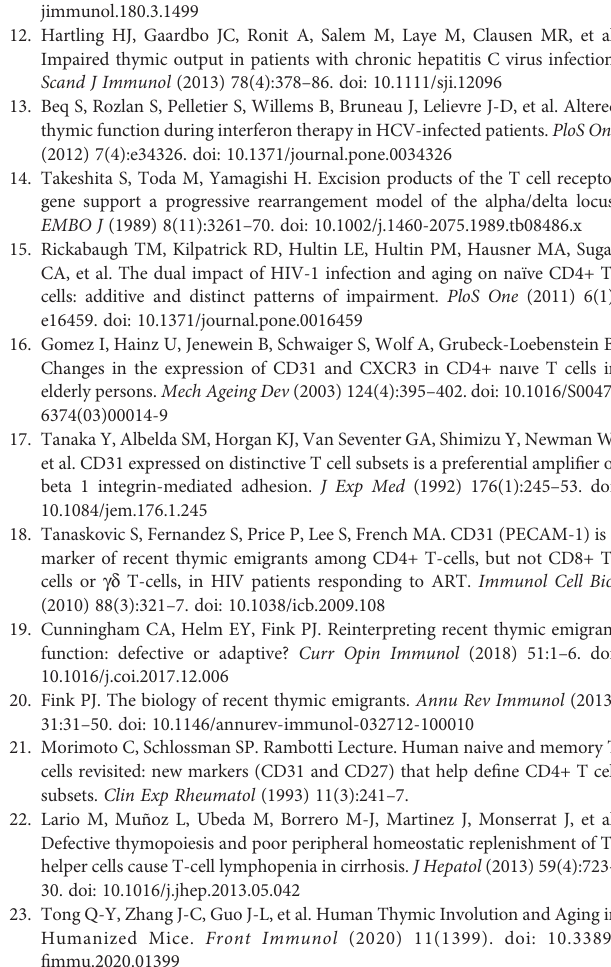
Supplementary Figure 1 | Flow cytometry gating strategy for naïve CD4+ T cells and corresponding subsets. Supplementary Figure 2 | Naïve CD4+, CD4+CD31+ and CD4+CD31- proportions and counts are lower in HCV infected individuals compared to age- range matched uninfected controls and initiation of direct-acting antiviral (DAA) therapy tended to increase naïve CD4+ and CD4+CD31+ but not CD4+CD31- counts. In alongitudinal cohort study, chronicHCV infected individuals were treated with 8 or 12 weeks of DAA therapy and followed from baseline (start; n=16) to time- points after DAA therapy initiation; Weeks 4 (n=13), 8 (n=6) and 24 (n=6). Proportions (A – C) and counts (D – F) of naïve CD4+ T cells (A and D), CD4+CD31+ T cells (B, E) and CD431+:CD31- T cell ratios (C, F) were assessed. Age-range matched uninfected controls (n=25) we compared for each T cell parameter. Wilcoxon signed rank test was used for paired comparisons between two time points; p= <0.05 considered signi fi cant. Supplementary Figure 3 | The degree of association between age and the naïve CD4+, CD4+CD31+ and CD4+CD31- proportions does not signi fi cantly differ before and after HCV DAA therapy. The associations between age and the naïve CD4+, CD4+CD31+ and CD4+CD31- T cell proportions in the chronic HCV infected ( fi lled circles, n=34) and HCV DAA-treated (open circles, n=29) groups and the differences between the two study groups were determined. R and p values for correlations within each group (HCV infected and HCV treated) are shown, and p values to determine differences in correlations between groups are shown. We can